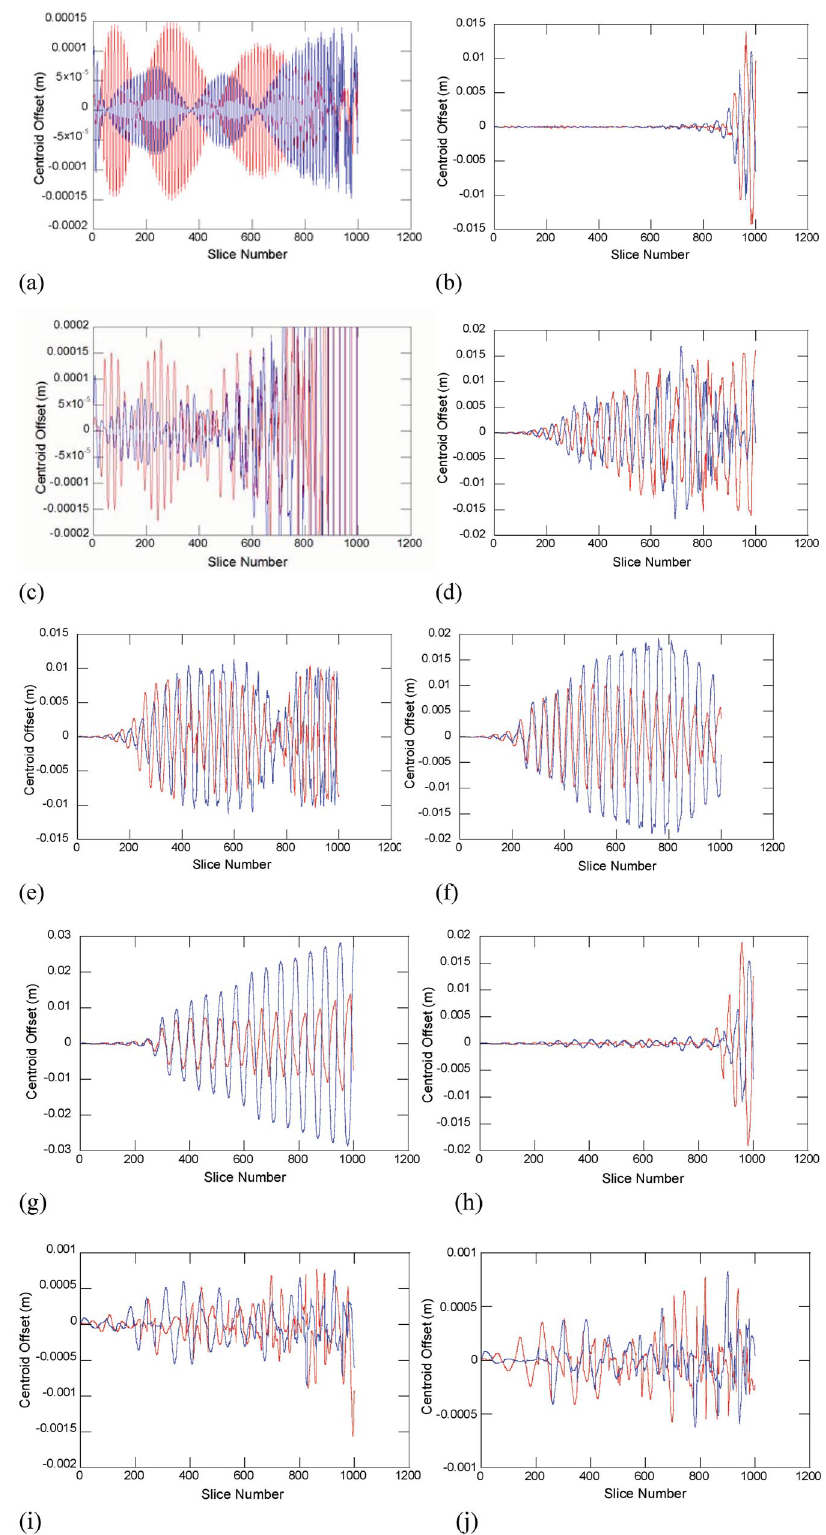
FIG. 26. (Color) Electron centroids at 12.5 m for an 8 (cid:1) sec beam ( 2 (cid:1) sec has elapsed by the 250th slice). The red line is for the horizontal offset and the blue line is for the vertical offset. (a) period of 96 nsec, (b) period of 200 nsec, (c) period of 200 nsec on different vertical scale, showing same envelope as the 96 nsec case, (d) period of 304 nsec, (e) period of 352 nsec, (f) period of 400 nsec, (g) period of 440 nsec, (h) period of 480 nsec, (i) period of 520 nsec, and (j) period of 600